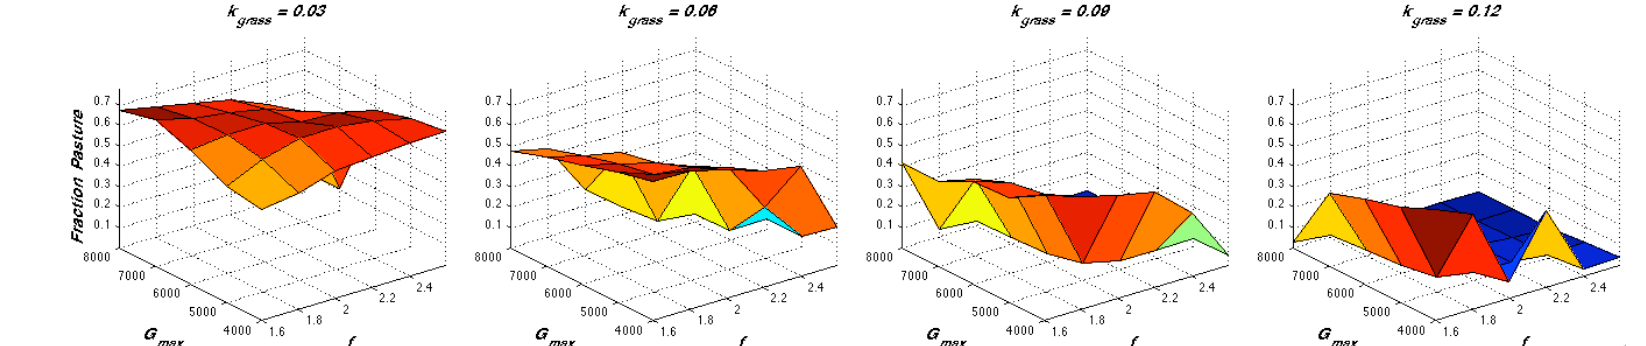
Figure A2.8: Fraction of property in pasture across dimensions of grass capacity G growth rate k (/t). Individual surfaces show pasture fraction as a function of grass capacity and stocking factor f at a constant intrinsic grass growth grass rate.